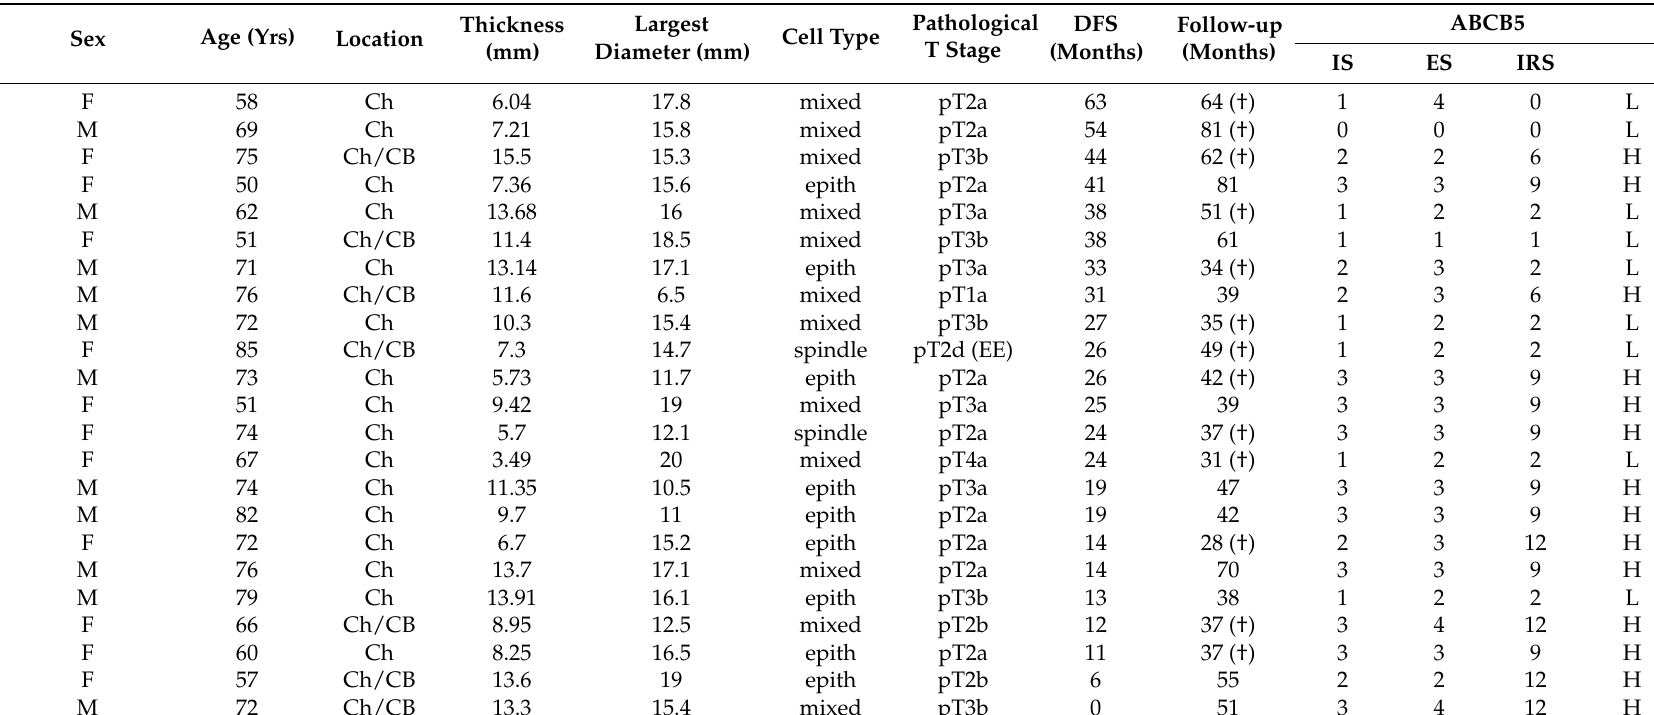
Table 2. Demographics, tumor parameters, disease free time, follow-up and ABCB5 expression in primary uveal melanoma with metastasis ( n =